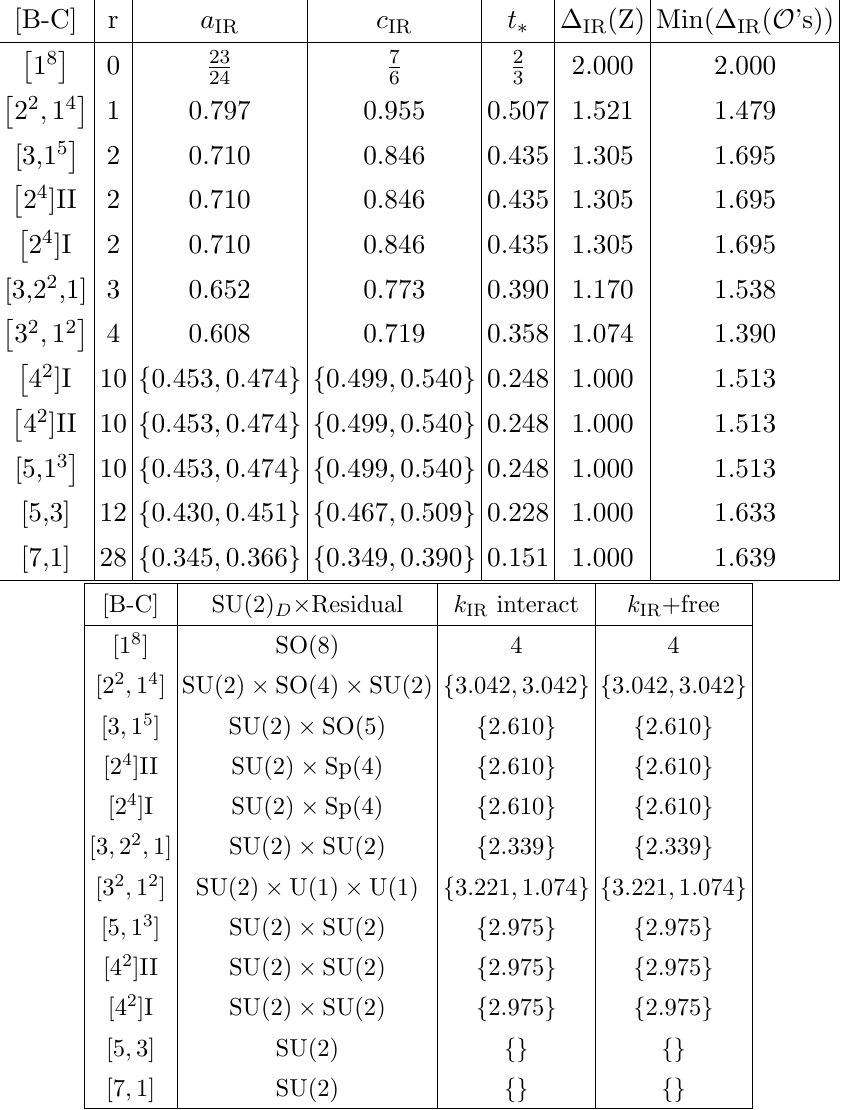
Table 9. Plain nilpotent deformations of the probe D3-brane theory with D 4 (cid:13)avor symmetry. The top table has the central charges a IR and c IR as well as scaling dimensions while the table below contains the information about the (cid:13)avor central charges.